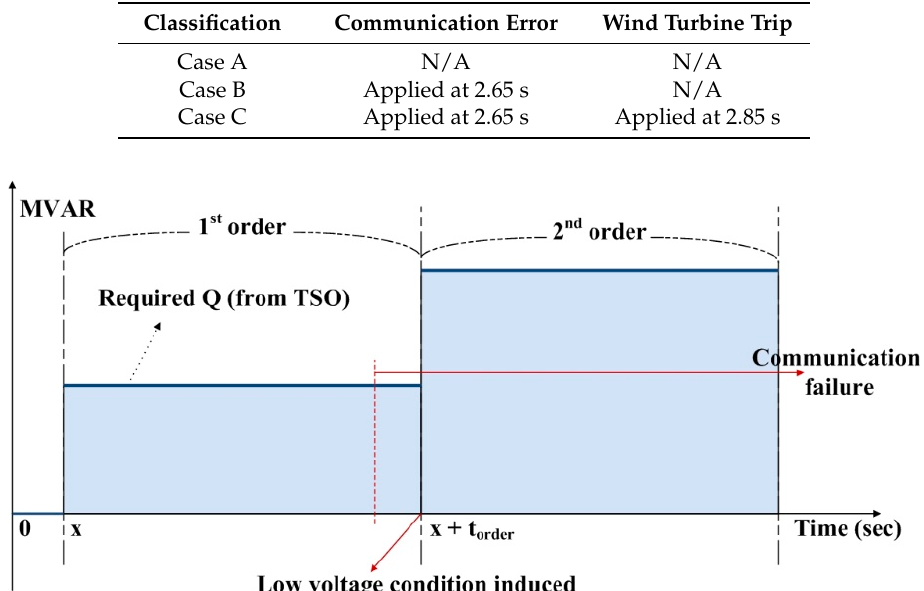
8 of 14 Table 1. Basic information for test system. Transmission System kV Table 2. Imposed numerical value in basic case study. Simulation Time